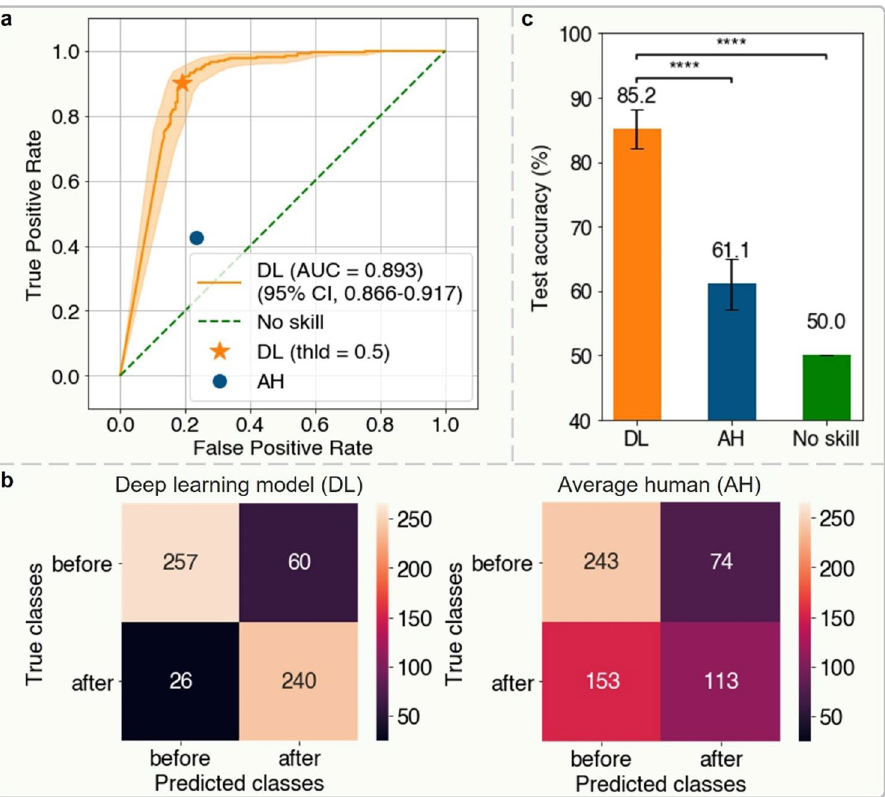
Figure 3. Results of image classification task by the ensemble deep learning model and the average human. ( a ) The receiver operating characteristic (ROC) curve of the performance of the ensemble deep learning (DL) model on testing frames. The 95% confidence intervals (CIs) of the ROC curve are indicated by the orange shaded area. The orange solid star represents the performance of the ensemble DL model with the default probability threshold of 0.5 to binarize its output and the dark blue solid circle represents the performance of the average human (AH), which is an aggregate result of six human volunteers’ prediction. We applied majority voting to the six predictions on each testing frame to obtain the average human performance. If each prediction received three votes, we randomly assigned a prediction of before or after onset. ( b ) Confusion matrix of image classification on testing frames by the ensemble DL model with the binarization threshold of 0.5 and the average human. c Testing accuracy bar chart of the ensemble DL model and the average human compared with no skill (random predictions), where the error bars represent the 95% CI. The ensemble DL model significantly outperforms the average human, and the no skill predictions. * p < 0.05, ** p < 0.01, *** p < 0.001, **** p < 0.0001, NS, not significant, two-sided z -test. All the 95% CIs are estimated by bootstrapping the testing dataset with 1000